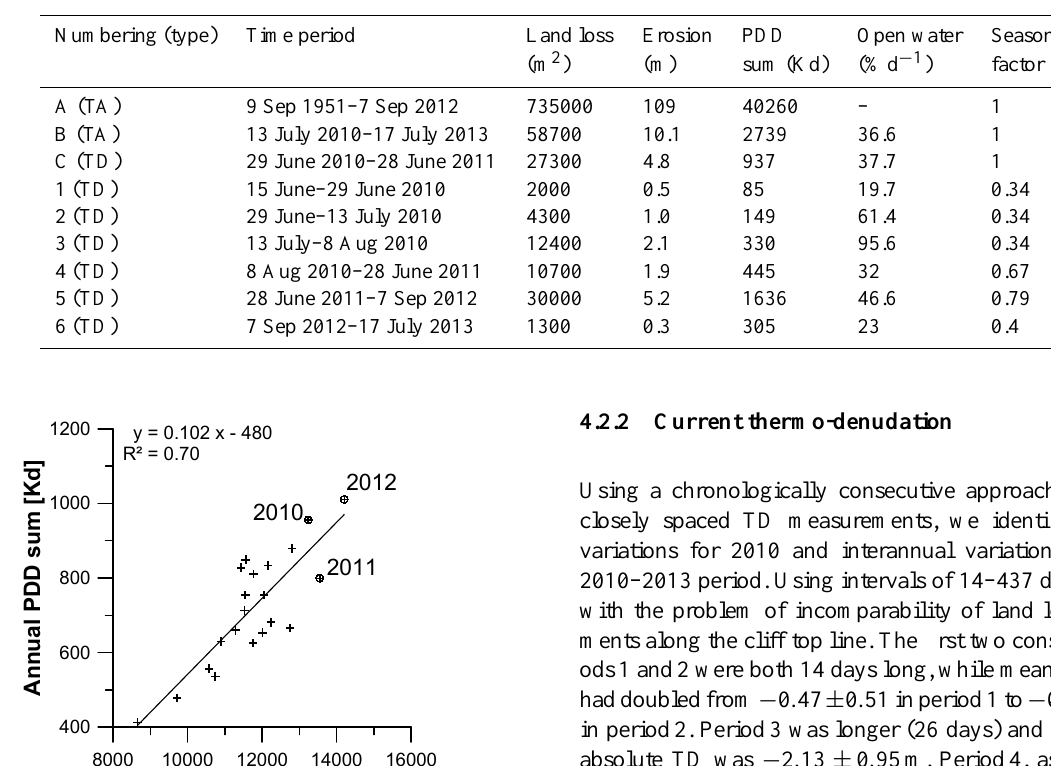
Table 3. List of time periods used for coastal thermo-erosion change detection, bracketed by data acquisitions. Periods referred to as letters correspond to observations covering more than or exactly 1 year. PDD sums were considered as indicators for possible ground ice melt. TD was season-corrected using the number of days with positive mean daily T air occurrence, while TA observations along the cliff bottom did not require correction through open water fraction, because of identical observation period start and end dates.